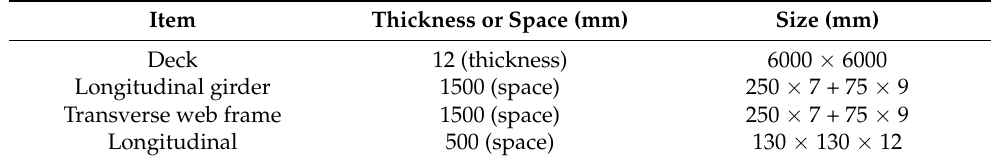
Table 4. Scantlings of the deck